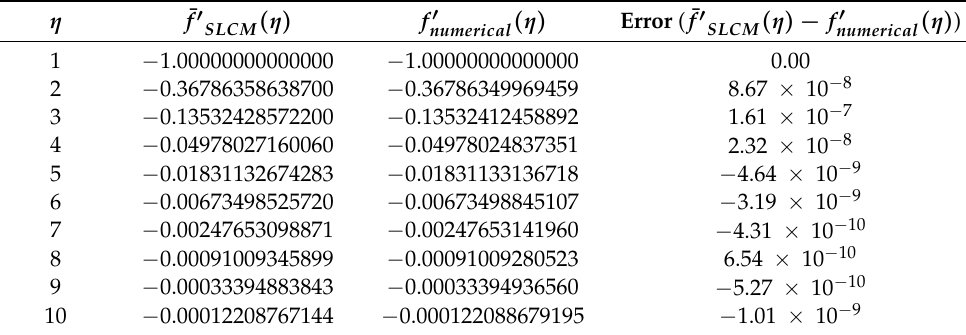
Table 5. Estimations of error for f (cid:48) ( η ) for λ = 1 (suction) by setting S = − 1.0, M = 0.0, φ s 1 = 0.0, φ s 2 = 0.0, Ec =